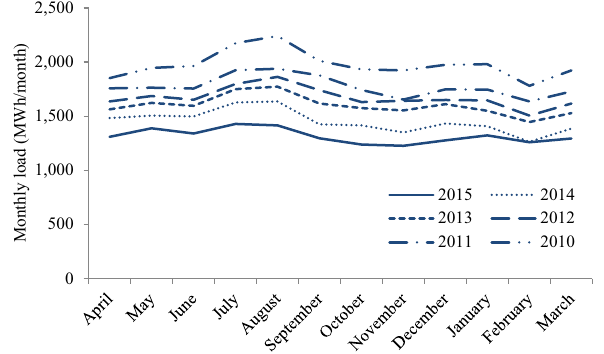
Fig. 3 Changes in electric energy consumption at Tokyo Branch Office building of JR East